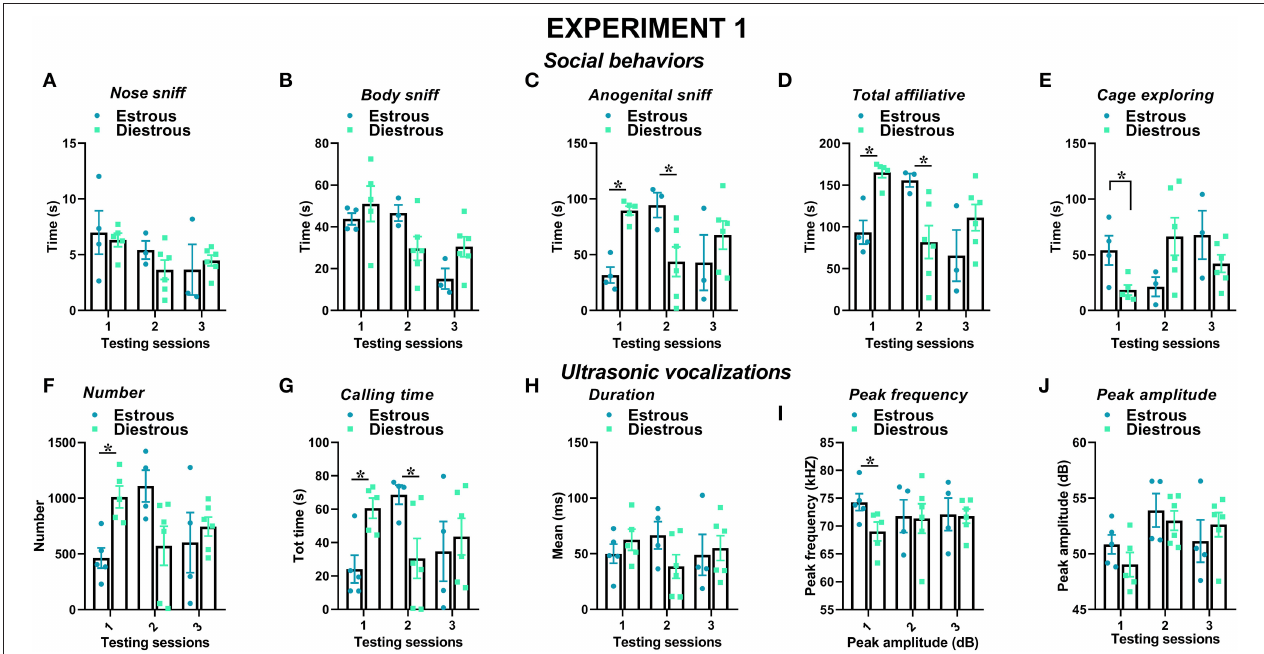
FIGURE 5 | Effects of the estrous phase of the resident female mice on social behaviors and USVs in experiment 1 (same pre-testing isolation). The impact of the estrous phase of the experimental female B6 subjects was investigated on each testing day on social behaviors (A–E) and USVs’ characteristics (F–J) . All the B6 mice were isolated for 3 days in the testing cage before each social encounter. For the exact number of mice in each estrous phase, refer to Table 1 . Data are mean ± SEM. Total N = 10 before exclusion of statistical outliers by Grubb’s test for small samples.* p <